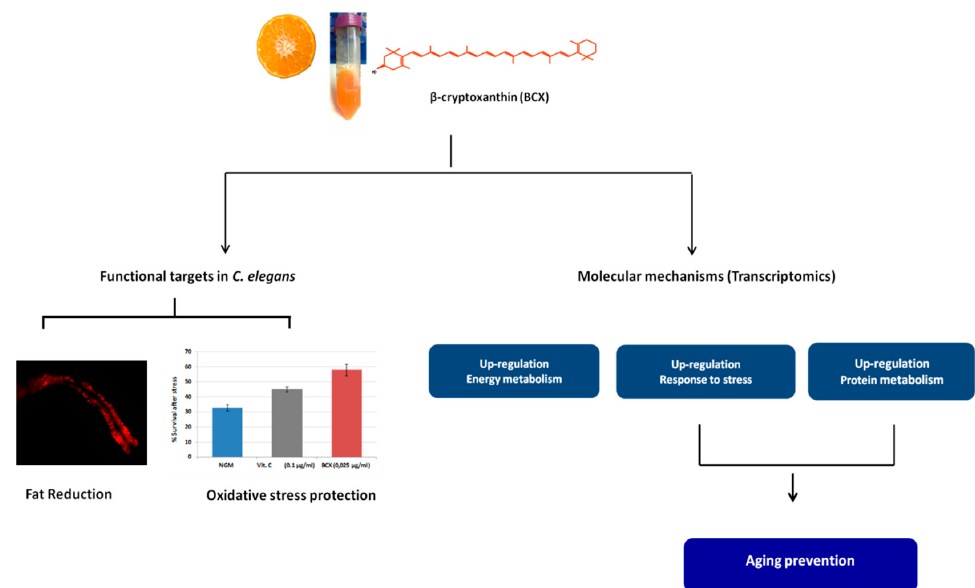
Figure 6. Model of the mechanism of action proposed for β‐ Cryptoxanthin (BCX) in C. elegans . Analysis of phenotype showed the efficacy of BCX on fat reduction and protection upon oxidative stress. The transcriptomic study provided the molecular mechanisms underlying these bioactivities, being the energy metabolism, the response to stress, and the protein metabolism the processes upregulated by BCX. NGM: nematode growth medium. VIt. C: Vitamin C.